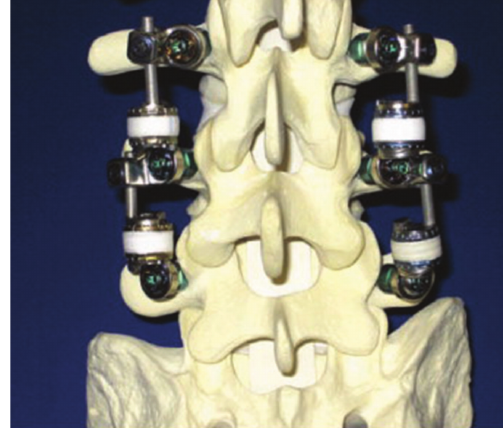
Figure 16: Stabilimax NZ device.